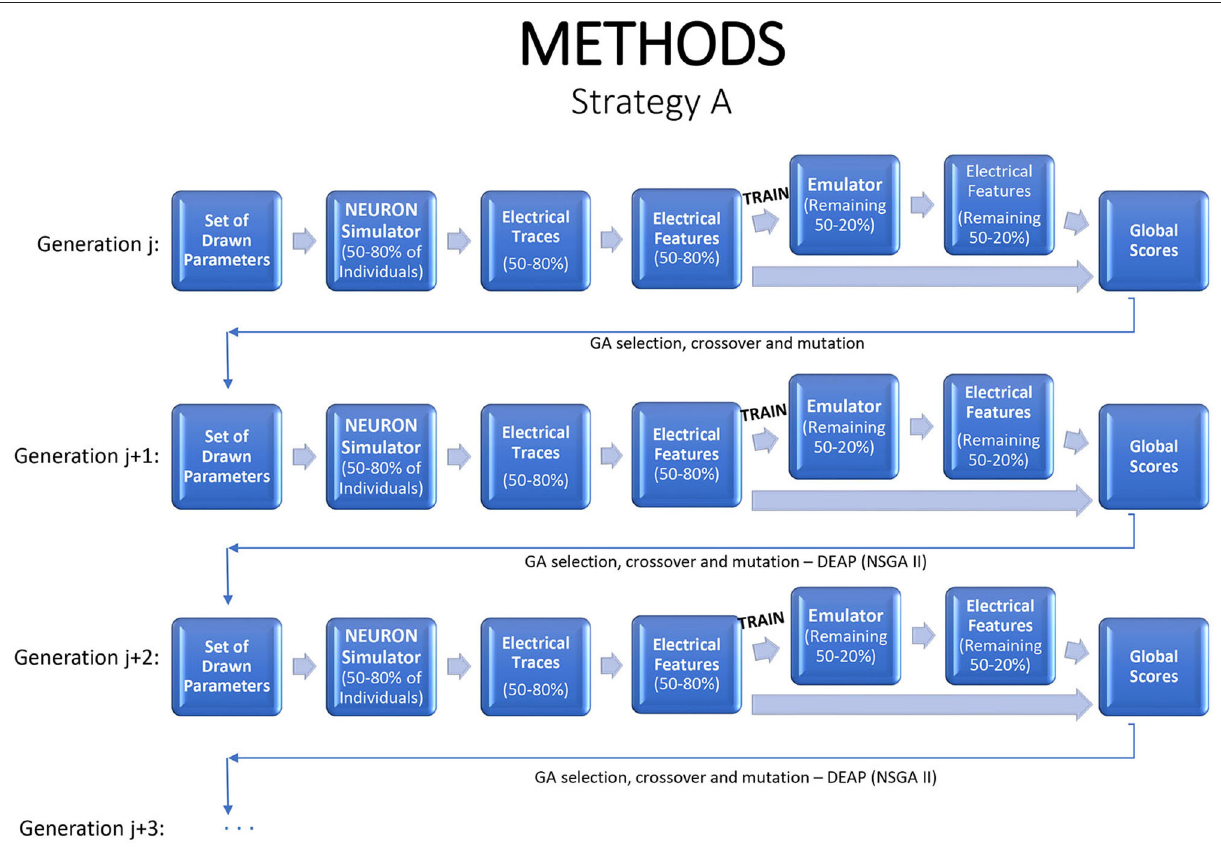
Frontiers in Big Data |